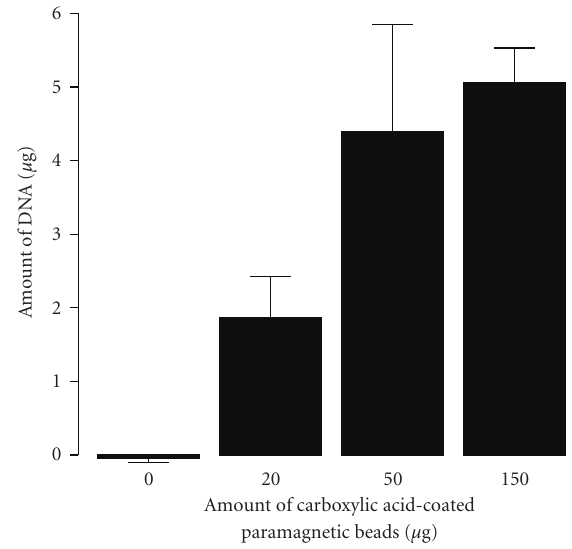
Figure 2: Binding capacity of the carboxylic acid-coated paramag- netic beads. Concentration of cDNA is measured before coupling to